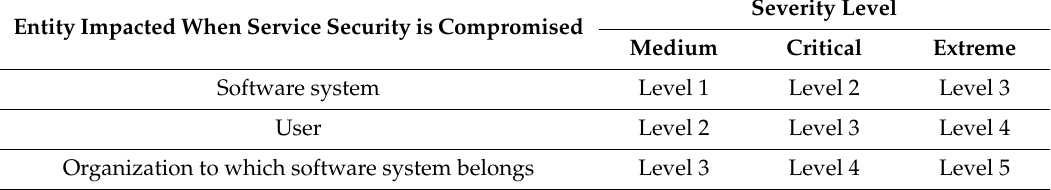
Table 6. Determination matrix for service security level.